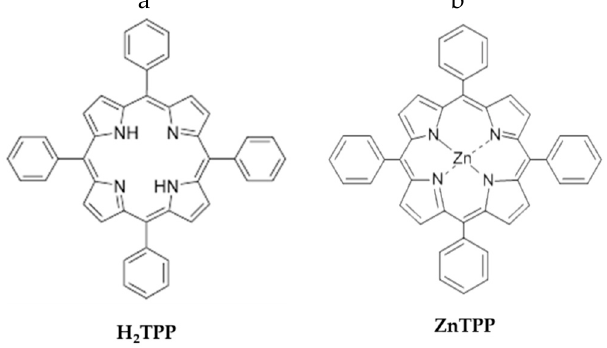
Figure 1. ( a ) Structure of meso-tetraphenyl porphyrin; ( b ) Structure of zinc(II) meso-tetraphenyl porphyrin.